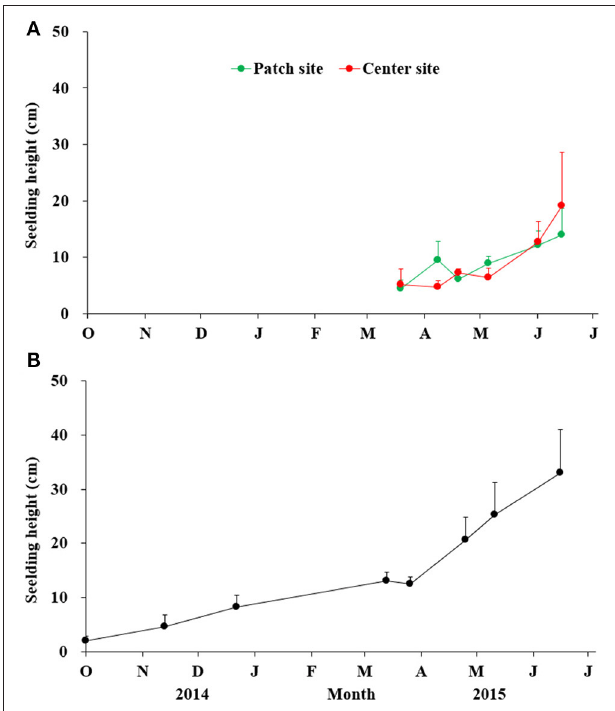
FIGURE 9 | The seedling heights of Zostera marina in Swan Lake (A) and Huiquan Bay (B) . Values are means ± sd .